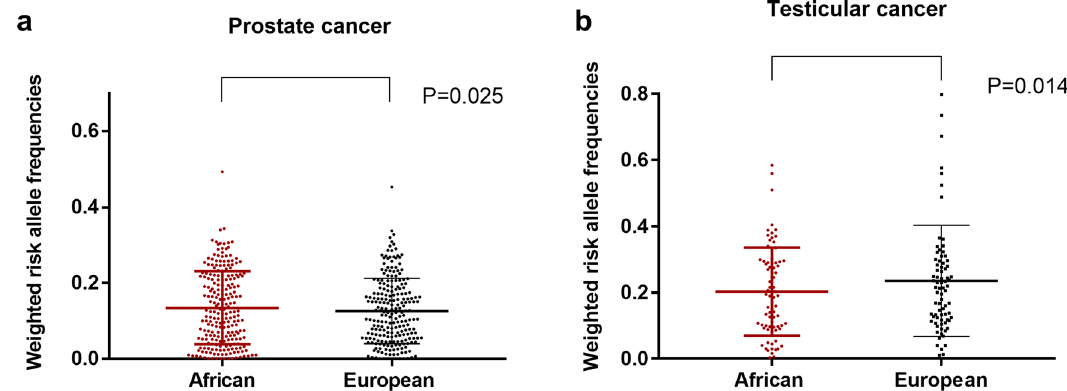
Fig. 1 Comparison of risk allele frequencies of prostate and testicular cancers between men of African descent and European descent. a Average weighted risk allele frequency of prostate cancer was signi fi cantly higher in men of African descent compared to men of European ancestry descent ( n = 226; p = 0.025). b Average weighted risk allele frequency of testicular cancer was signi fi cantly lower in men of African descent compared to men of European descent ( n = 79; p = 0.014).